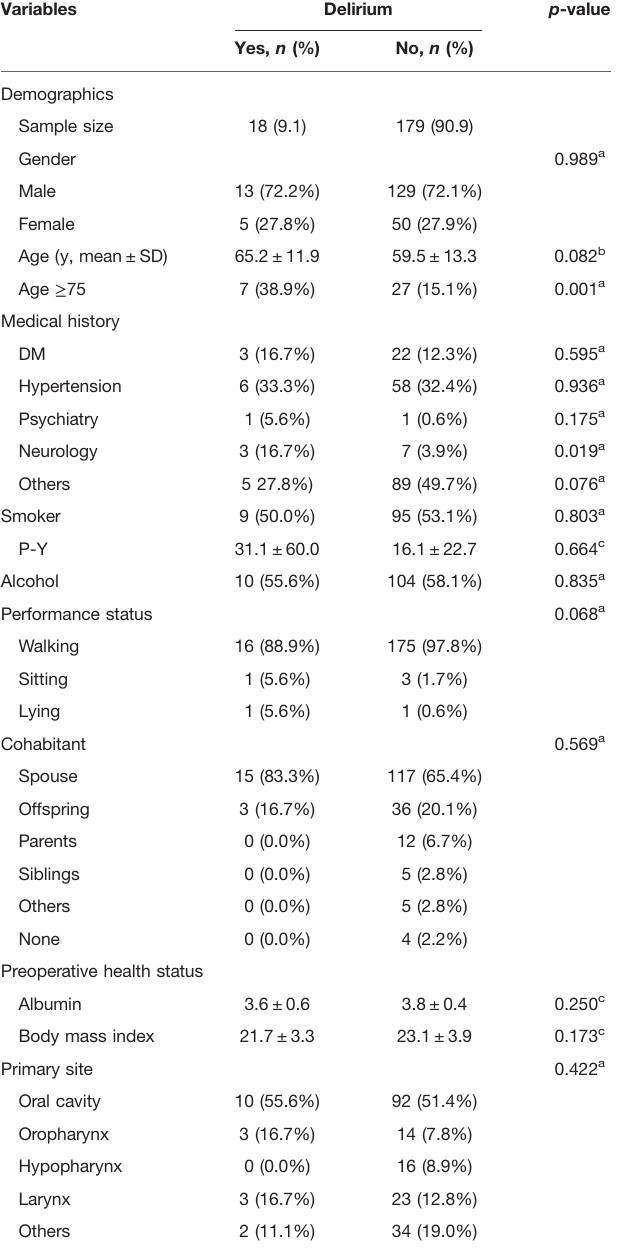
TABLE 1 | Characteristics and univariate analysis of preoperative factors related to delirium.